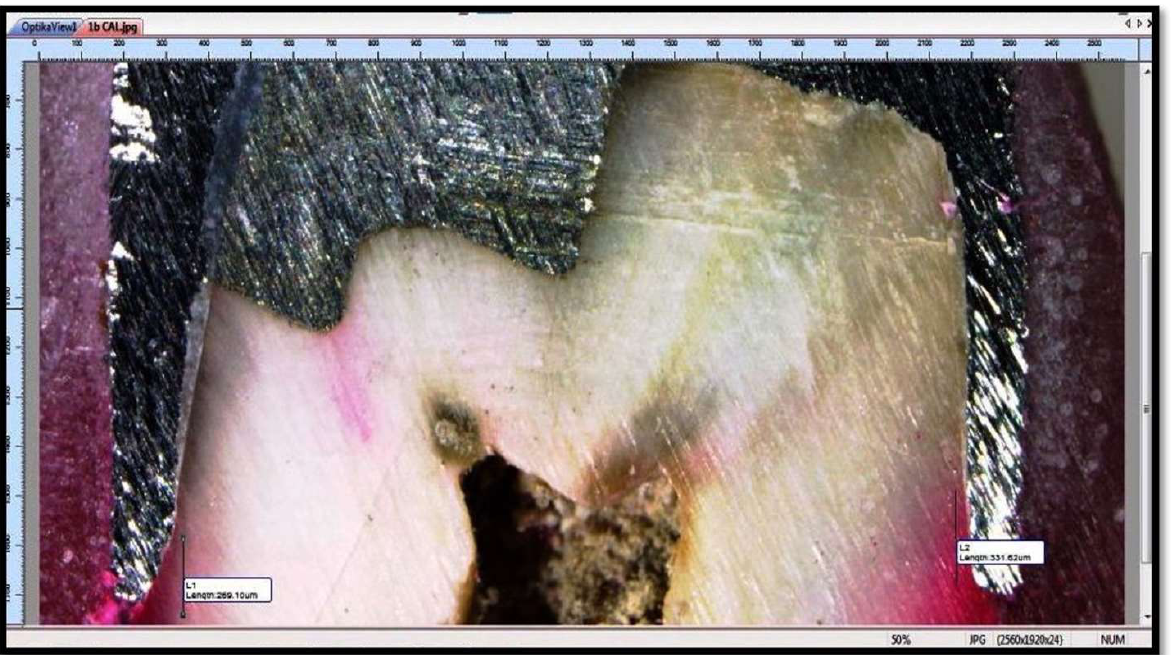
Figure 5. Microleakage was observed at tooth-metal crown and tooth-foundation material interfaces (Each sample was studied under microscope with 40X magnification to check for microleakage between tooth-metal crown and tooth-foundation material (amalgam or composite) interfaces.).